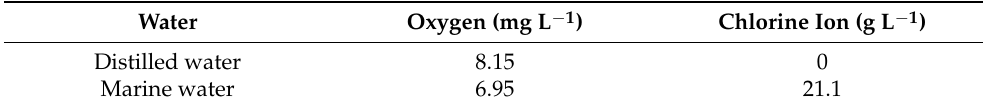
Table 1. Oxygen and chlorine ion in distilled and marine